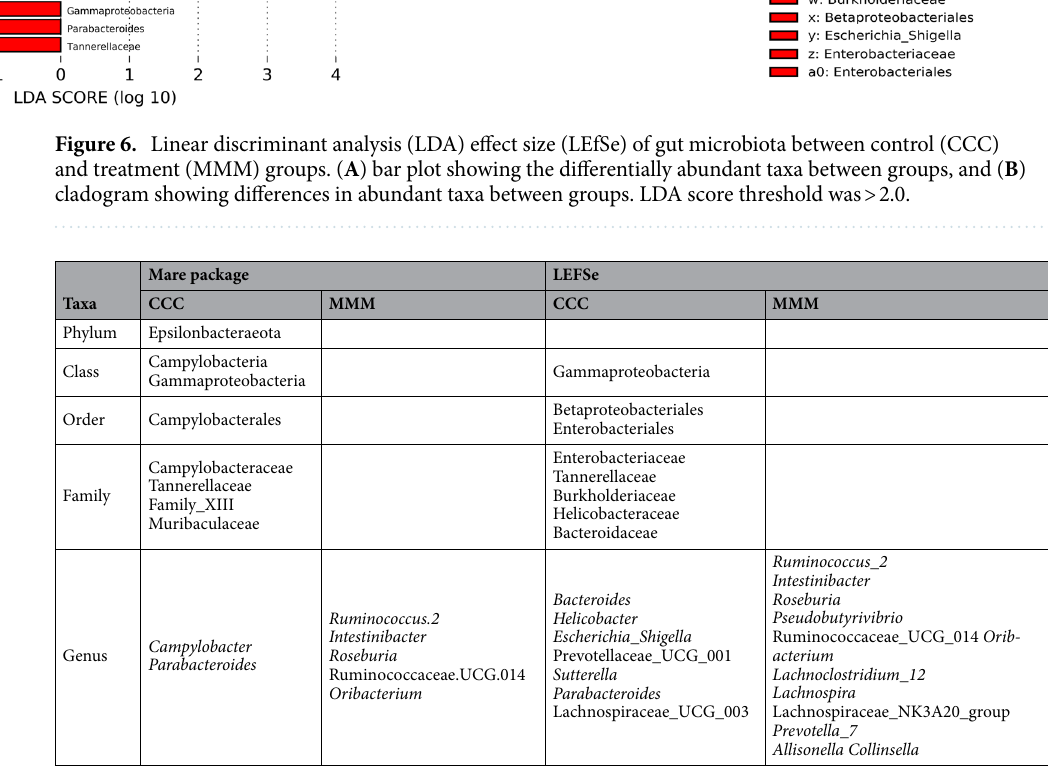
Table 3. Comparison of significant taxa based on relative abundance in Mare package, and estimated effect size (LEFSe) between control and MFC group. LEFSe linear discriminant analysis effect size; Control CCC; MFC MMM; CCC sow control feed, piglets fed control creep feed, piglets post-weaning control feed; MMM sow MFC, piglets fed MFC creep feed, post-weaning piglets MFC